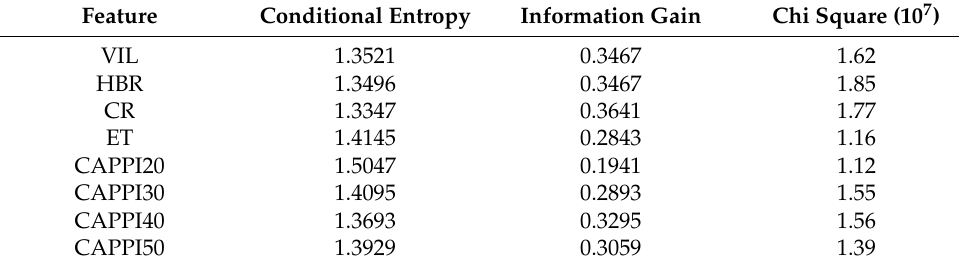
Table 2. Conditional entropy, information gain, and Chi-square of each radar features.